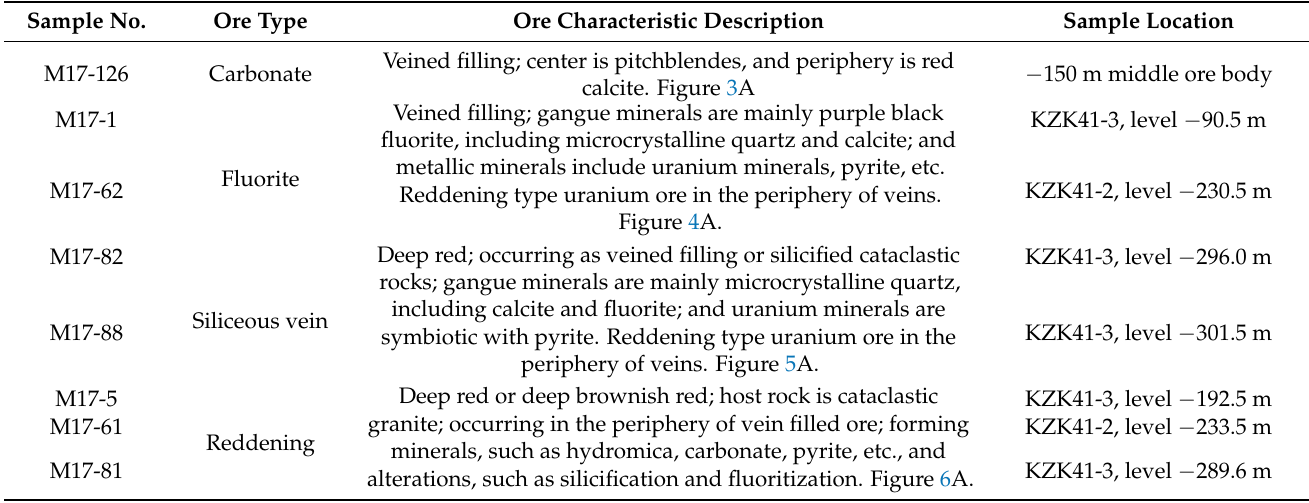
Table 1. Uranium ore sample characteristics and location in the Mianhuakeng deposit.